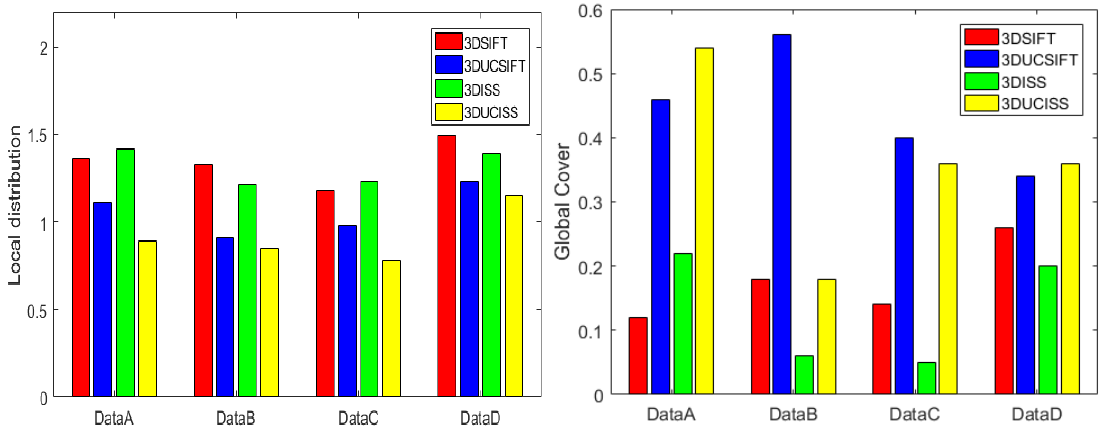
Figure 12. Results of spatial distribution criteria.